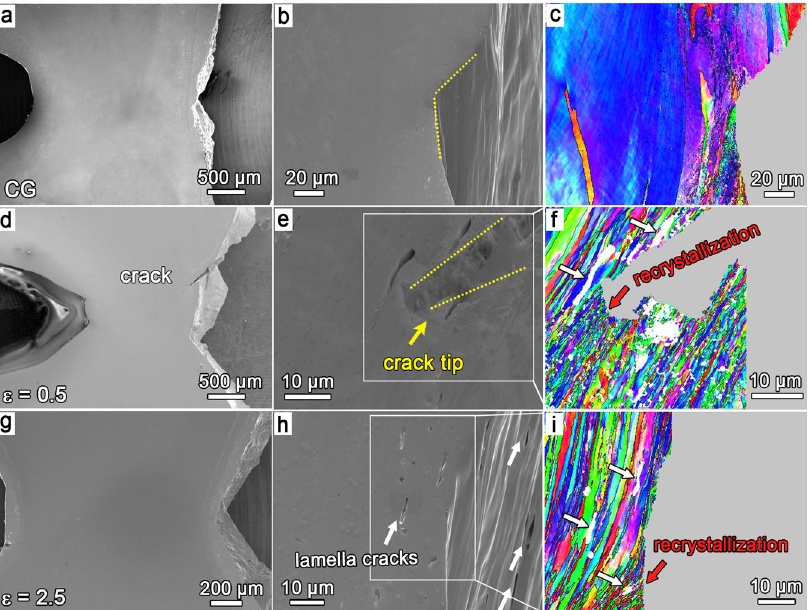
Fig. 4 Side-view SEM and EBSD images of the CG and swaged copper by Charpy V-notch impact at room temperature near the crack tip. a – c CG copper. d – f ε = 0.5. h , i ε = 2.5. Large number of isolate lamellar cracks along GBs at the front of main crack of the swaged copper was pointed out by white arrows in Fig. 4f, h,